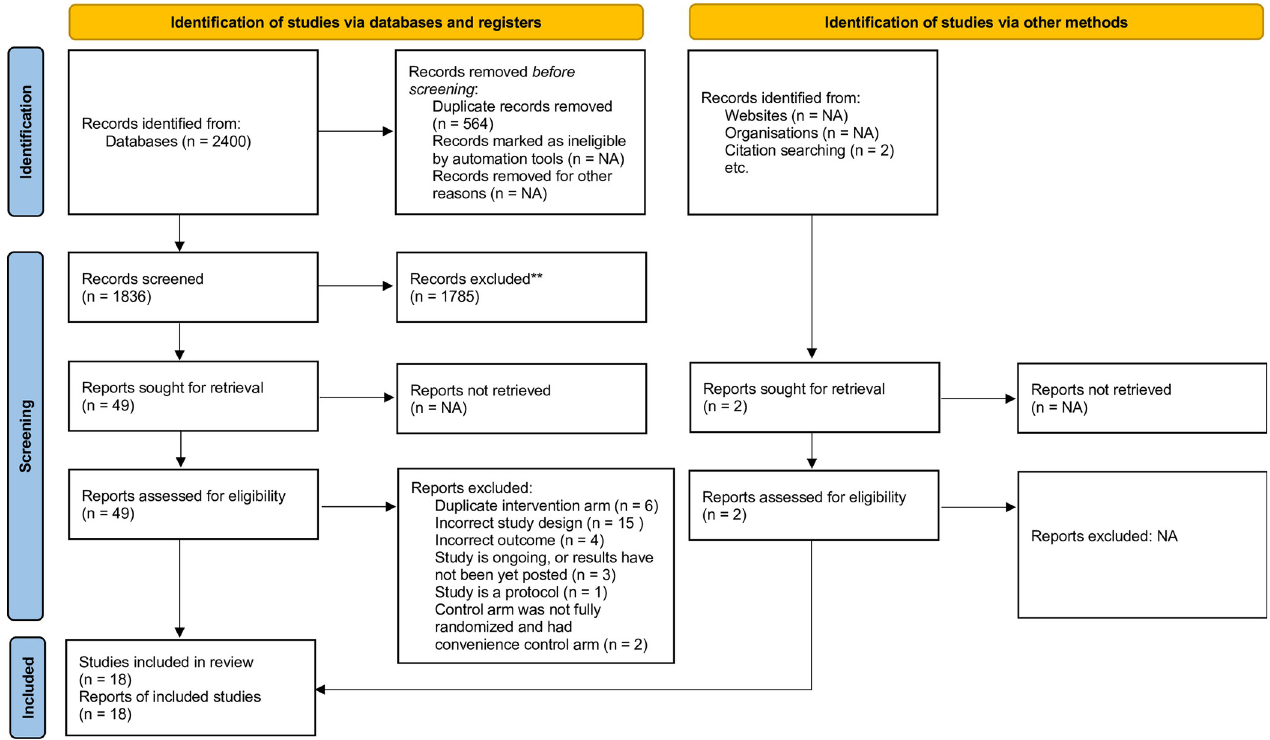
Fig 1. Prisma flow diagram of included